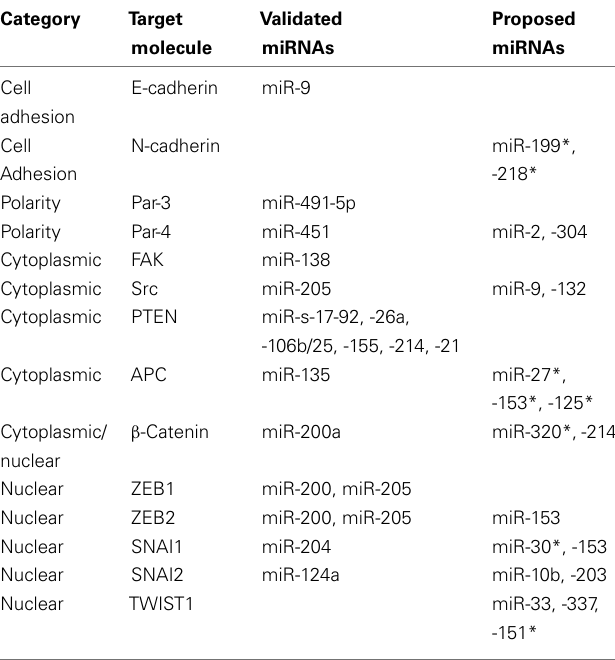
Table 1 | Predicted/validated microRNAs targeting the expression of invasion/EMT related